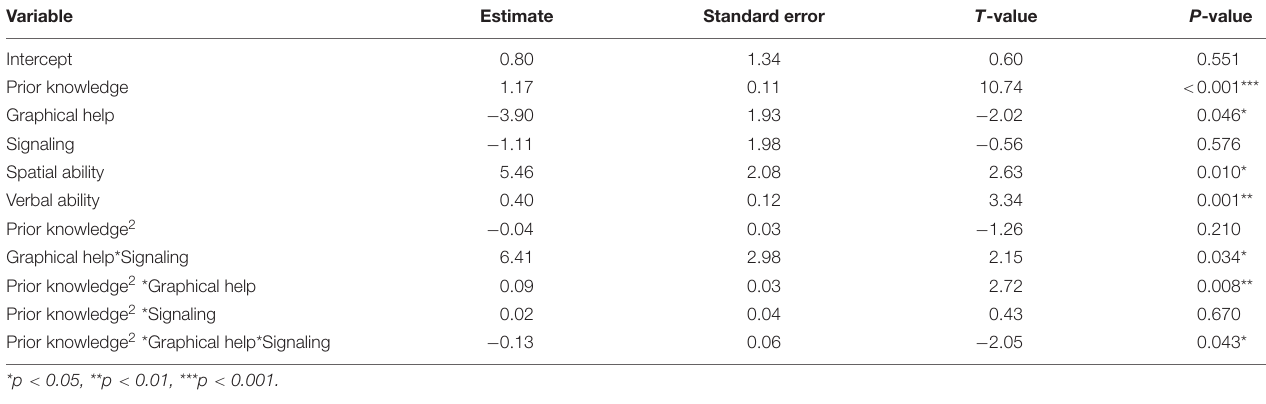
TABLE 3 | Multiple regression model including prior knowledge as quadratic moderator.